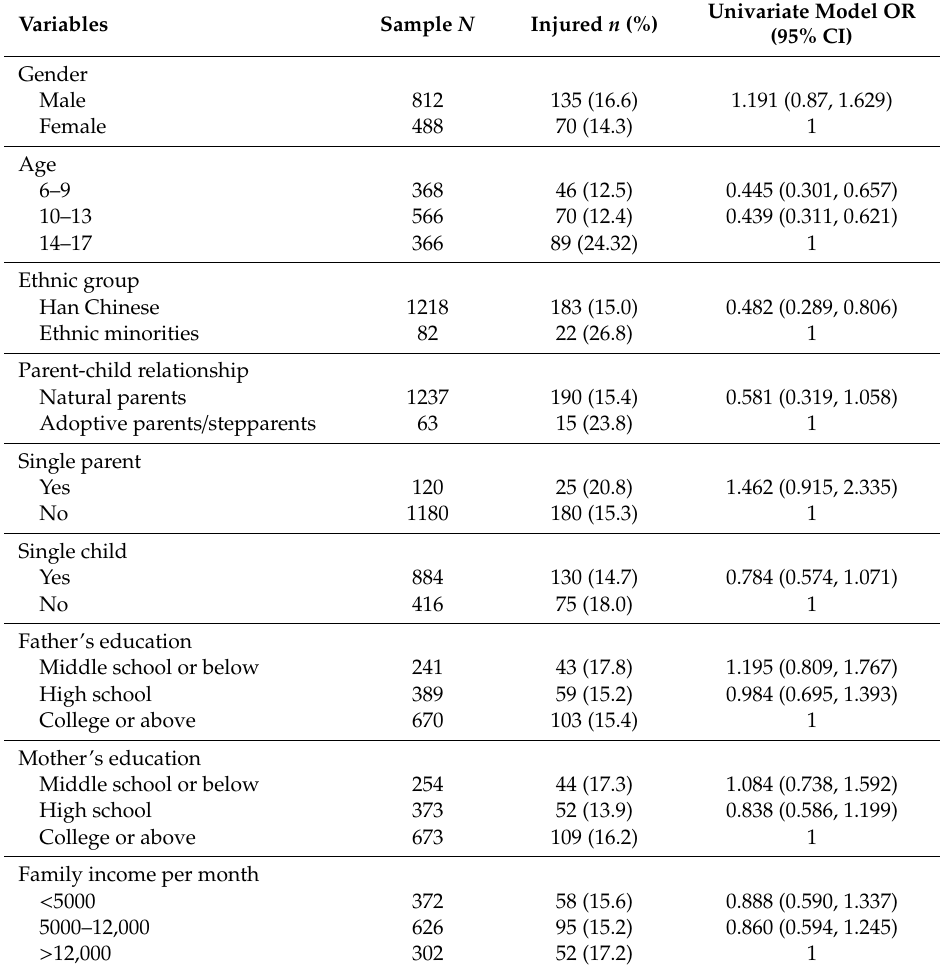
Table 3. Univariate logistic regression results of the DSH among children by sociodemographic factors in Beijing, China.